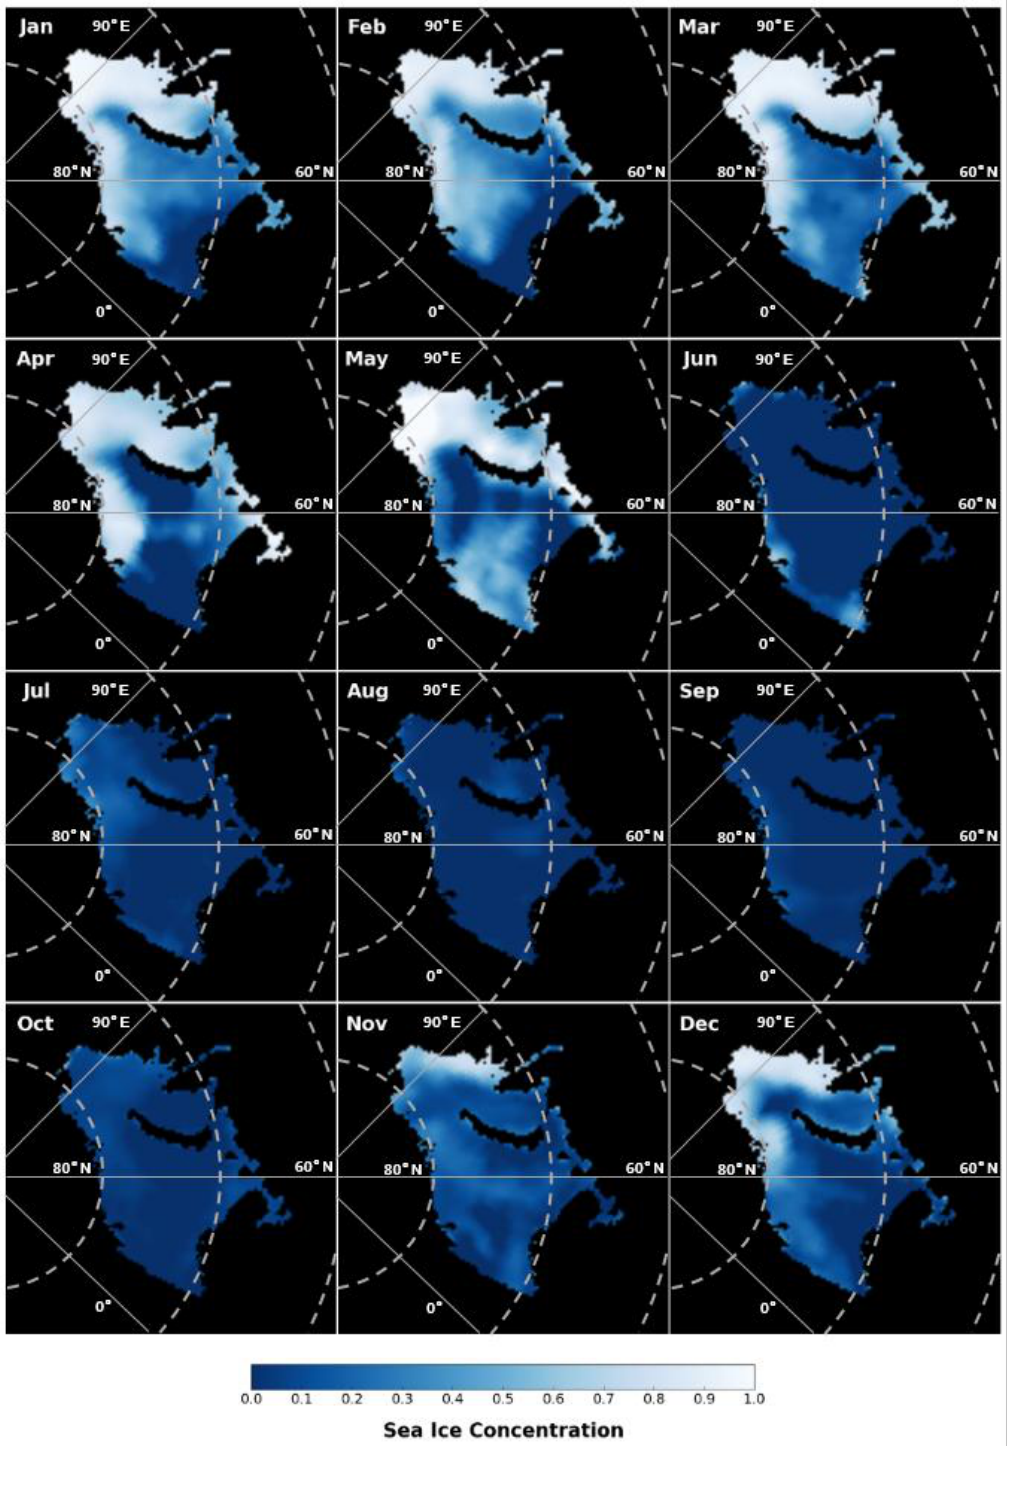
Figure 7. Monthly sea ice concentration predicted by the OLS regression models for the Barents and Kara Seas in